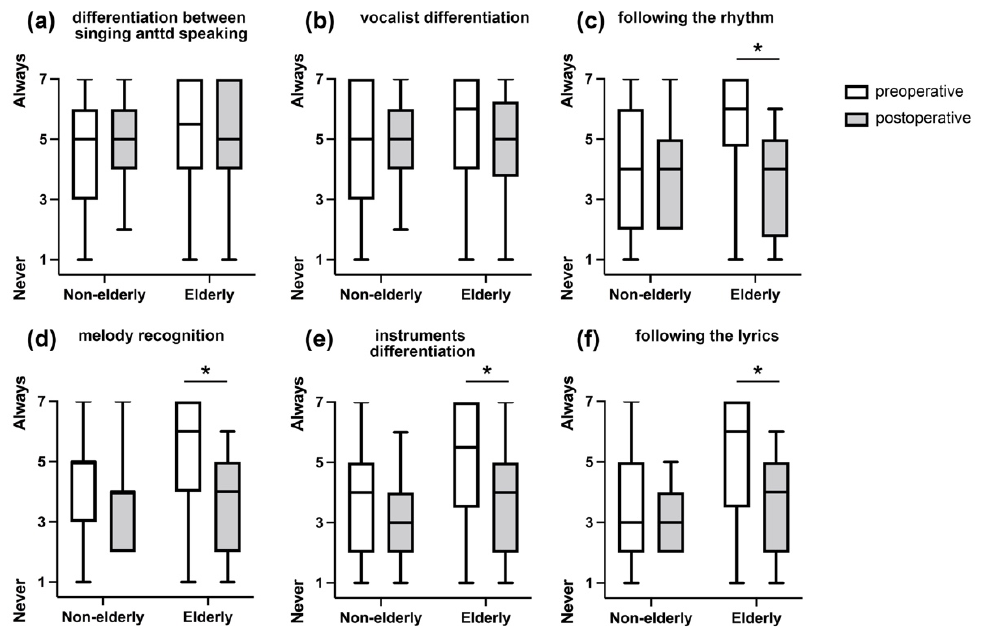
Figure 2. Comparison of music elements between the non-elderly group and the elderly group before and after receiving a cochlear implant. ( a ) Ability to perceive the difference between singing and speaking; ( b ) ability to differentiate between a male and a female vocalist; ( c ) ability to follow the rhythm; ( d ) ability to recognize the melody; ( e ) ability to differentiate the instruments; ( f ) ability to follow the lyrics. The elderly group shows significant declines in postoperative scores for rhythm, melody, timbre, and lyrics compared with their preoperative scores. No significant change is observed for any factor in the non-elderly group. * p < 0.05.